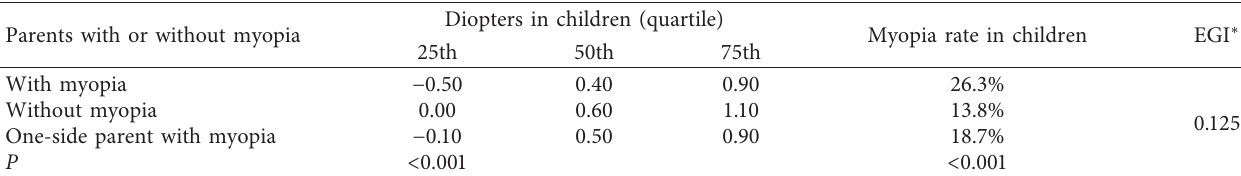
Table 4: Effect of environmental and genetic factors on myopia